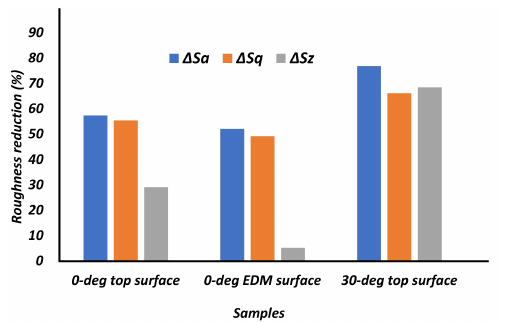
Figure 4. Reduction of surface roughness parameters (%) after bead blasting of the samples. bead blasting, in comparison with counterpart surfaces that were smoother to begin with. 218 For instance, the 0 ◦ EDM surface showed an average surface roughness of 1.87 µ m after 219 bead blasting. In comparison, the 30 ◦ top surface showed an average roughness of 15.78 µ m 220 after bead blasting. The sin 2 ψ method was used to measure residual stress on surfaces in as-received and shot peened states. This method relies of characterization of elastic normal strains from